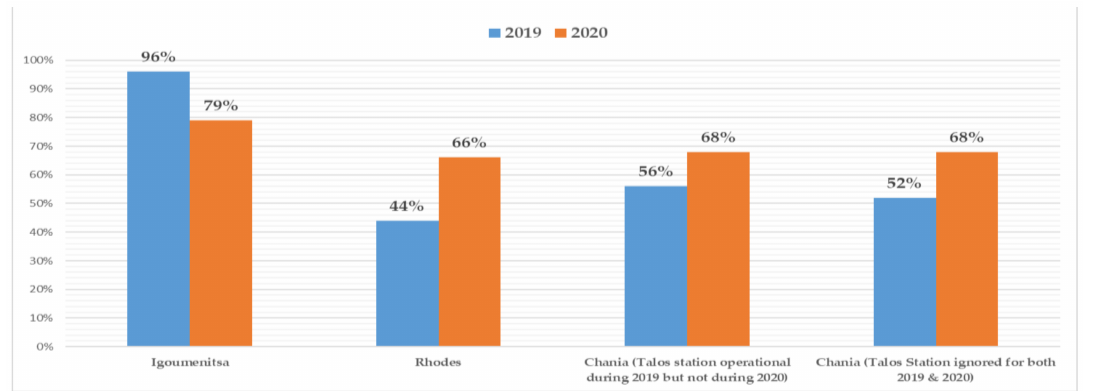
Figure 11. Percentage of BSS bicycles returned by the users to their initially rented station for